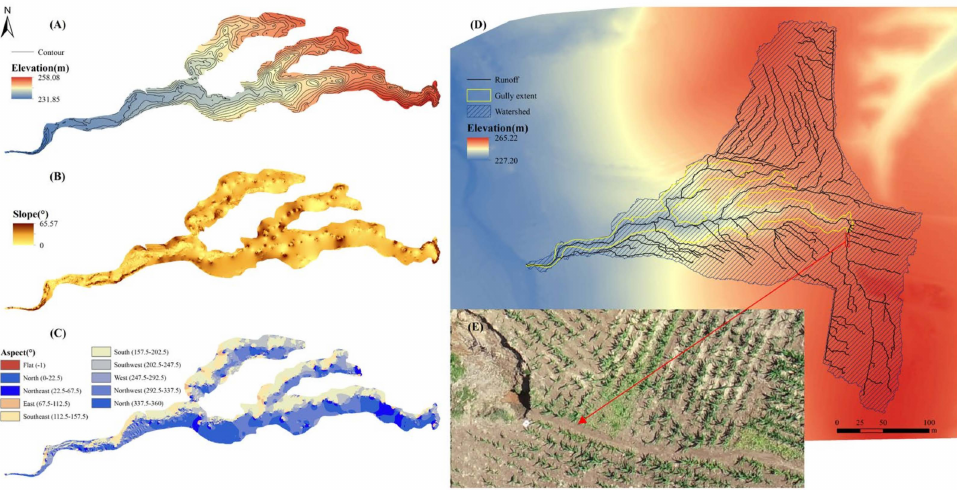
Figure 6. Topographic information of the gully: ( A ) elevation; ( B ) slope; ( C ) aspect; ( D ) watershed and runoff pathways; ( E ) P4R UAV photo of a concentrated runoff pathway in the upstream area draining to the gully headcut, obtained on 1 July